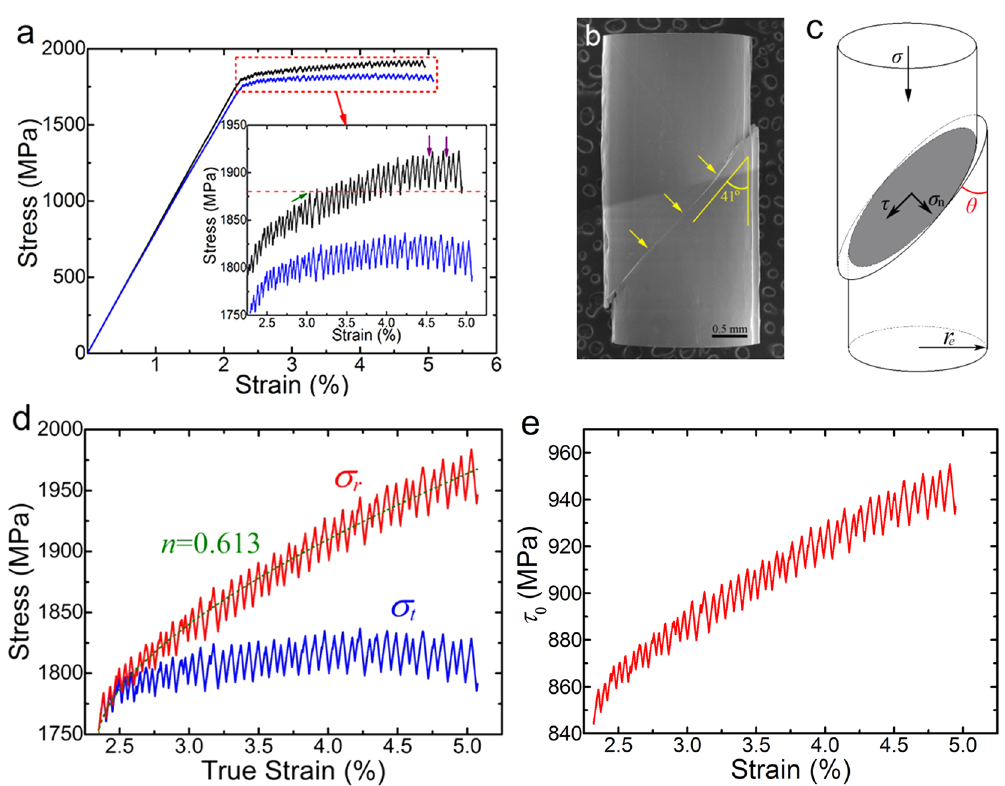
Figure 3. The investigation on the deformation behavior in Zr 50 Cu 44 Al 6 MG under compression. ( a ) The engineering (black) and true (blue) stress-strain curves and the inset magnifying the plastic regime. ( b ) The SEM image of the deformed sample in which the primary shear band is marked by the arrows. ( c ) A schematic illustration of the effective load-bearing area in the rod sample. ( d ) The real stress (red) calculated using the area A in Eq. (2) showing the hardenability in Zr 50 Cu 44 Al 6 MG with a strain hardening coefficient n = 0.613. ( e ) The intrinsic shear strength calculated by Eq. (4) shows a hardening behavior